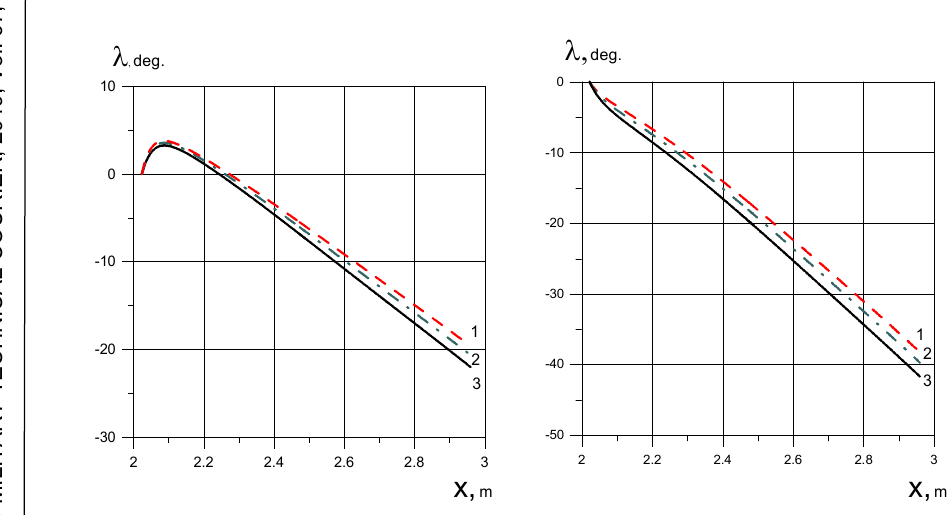
Figure 11 – Calculated values of the angle λ of the contact of the projectile with the guide (Fig. 5) along the length of the section x spatial movement with a slope angle of of the screw 2.5 0 and the initial angular coordinate of the screw groove φ п 0 = 15 0 (left) and φ п 0